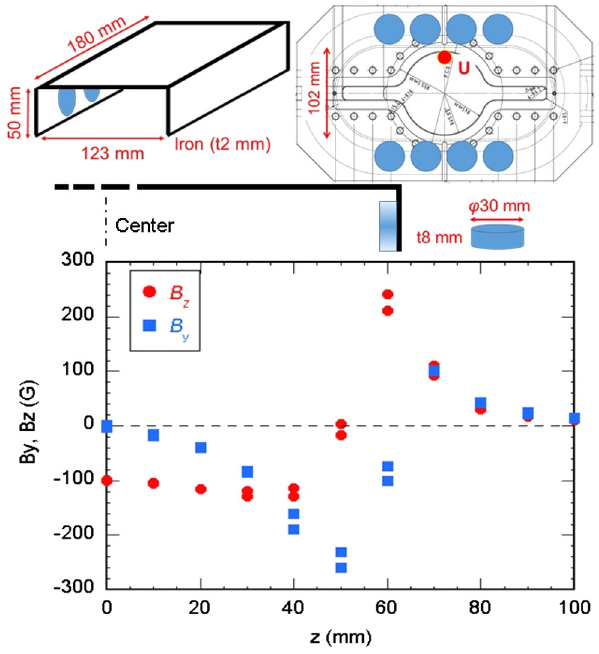
FIG. 12. Measured vertical (y) and axial (z) magnetic fields inside a yoke on the upper inner wall of the beam channel (point U in the